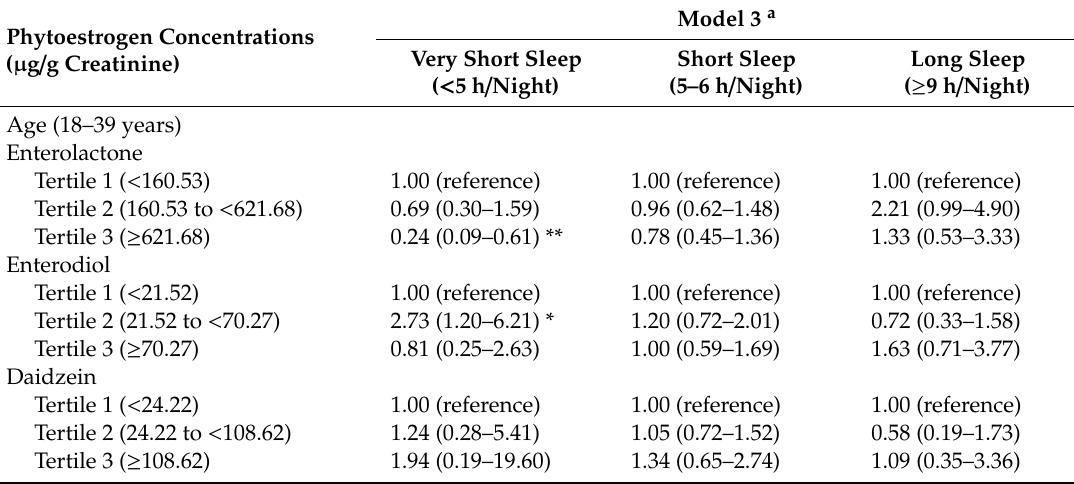
Table 8. Weighted relative risk ratios (95% confidence intervals) for sleep duration (reference, 7–8 h / night) across tertiles of the urinary phytoestrogen concentrations stratified by age (National Health and Nutrition Examination Survey